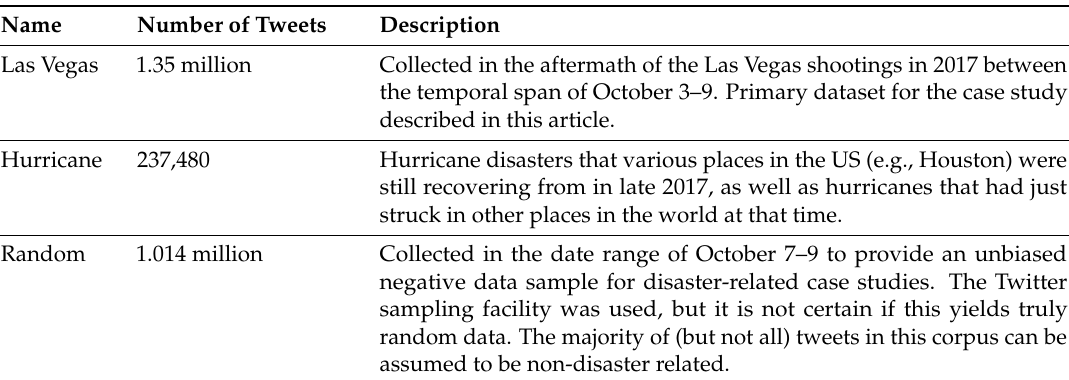
Table 1. Datasets collected for case